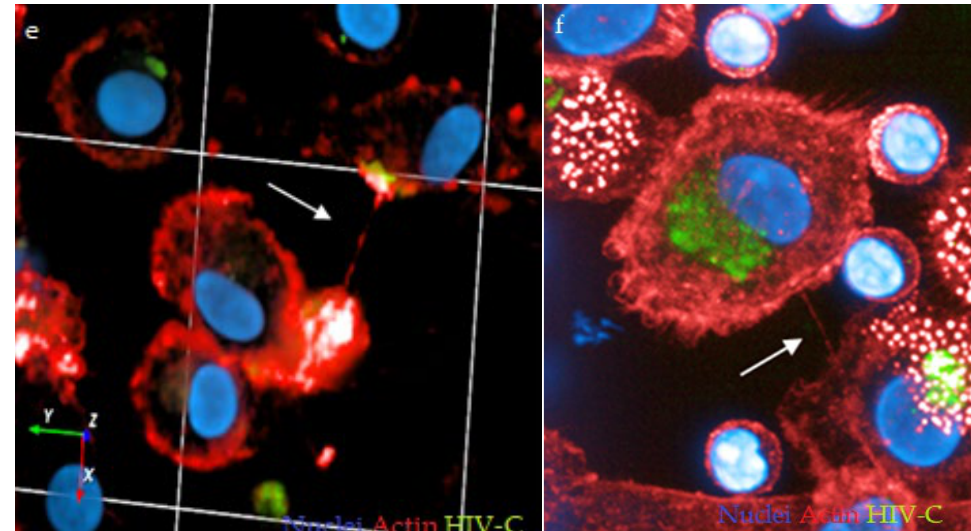
Figure 1. HIV-C increases TNT formation and infection in immature (i) and mature (m) DCs. ( a ) Quantification of TNTs on HIV/HIV-C-loaded i/mDCs in co-cultures with CD4 + T cells at 7 dpi. HIV infection induces TNT formation in both i- and mDCs, with complement opsonization of the virus significantly enhancing this tendency ( p < 0.0001). Experiments were performed for a minimum of 3 independent replicates, and statistical significance was analyzed using GraphPad Prism software v9 [60] and ordinary one-way ANOVA. ( b ) TNT formation in GFP-HIV-C-infected DC/CD4 + T-cell co-culture was observed by confocal microscopy with the high-content screening Operetta system (Perkin Elmer). Nuclei were stained with Hoechst (blue), and F-actin (and therefore TNTs) was stained with phalloidin (red). HIV-C is visible in green. A TNT (highlighted with a white arrow) connects a DC and a CD4 + T cell. In the absence of cellular membrane staining, CD4 + T cells can be distinguished from DCs as round cells with a smaller diameter. Objective: 63×. The acquired image belongs to a single Z-stack, above the cells’ substratum. ( c ) TNT formation in a DC culture infected with mCherry HIV-C was observed by confocal microscopy with the high-content screening Operetta system (Perkin Elmer). Nuclei were stained with Hoechst (blue), F-actin (and therefore TNTs) was stained with phalloidin (fuchsia), and C3 was stained with FITC (green). HIV-C is visible as a yellow spot inside cells. A TNT (indicated by a white arrow) typically lies above cells’ substratum and connects two infected DCs. Objective: 63×. Z-series images were acquired at minimal Z interval and later processed together into the “Maximum projection” mode with Harmony software v 4.8 (Perkin Elmer) [58]. ( d ) TNT quantification on HIV-C-loaded DCs and DC/CD4 + T-cell co-cultures at 7 dpi. HIV-C-infected DCs, both alone and in a co-culture with CD4 + T cells, show a significantly higher number of TNTs on their surfaces. Experiments were performed for a minimum of 3 inde- pendent replicates, and statistical significance was analyzed using GraphPad Prism software v9 [60] and unpaired Student’s t -test. ( e ) A 3D reconstruction of a TNT connection (indicated by a white arrow) between GFP-HIV-C-infected DCs. Nuclei were stained with Hoechst (blue), and F-actin (and therefore TNTs) was stained with phalloidin (red). HIV-C is visible in green. Objective: 63 × . Z-series images were acquired at minimal Z intervals and later processed together into the “Maximum projec- tion” mode. From this image, a 3D reconstruction was obtained with the Harmony software (Perkin Elmer) v4.8 [58]. ( f ) TNT formation in GFP-HIV-C-infected DC/CD4 + T-cell co-culture was observed by confocal microscopy with the high-content screening Operetta system (Perkin Elmer). Nuclei were stained with Hoechst (blue), and F-actin (and therefore TNTs) was stained with phalloidin (red). HIV-C is visible in green. A TNT (indicated with a white arrow) connects two HIV-C-loaded DCs. In the absence of cellular membrane staining, CD4 + T cells can be distinguished from DCs as round cells with a smaller diameter. Objective: 63 × . The acquired image belongs to a single Z-stack, above the cells’